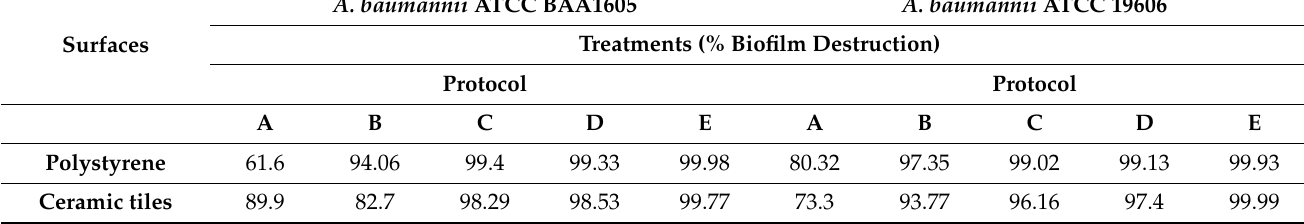
Table 1. Percentages of inhibition of both A. baumannii strains of biofilm formed on polystyrene and ceramics after disinfection protocols. Protocol A marks disinfection with gaseous ozone, Protocol B disinfection with citric acid, Protocol C a combination of citric acid–gaseous ozone, Protocol D a combination of gaseous ozone–citric acid, and Protocol E a combination of citric acid–gaseous ozone–citric